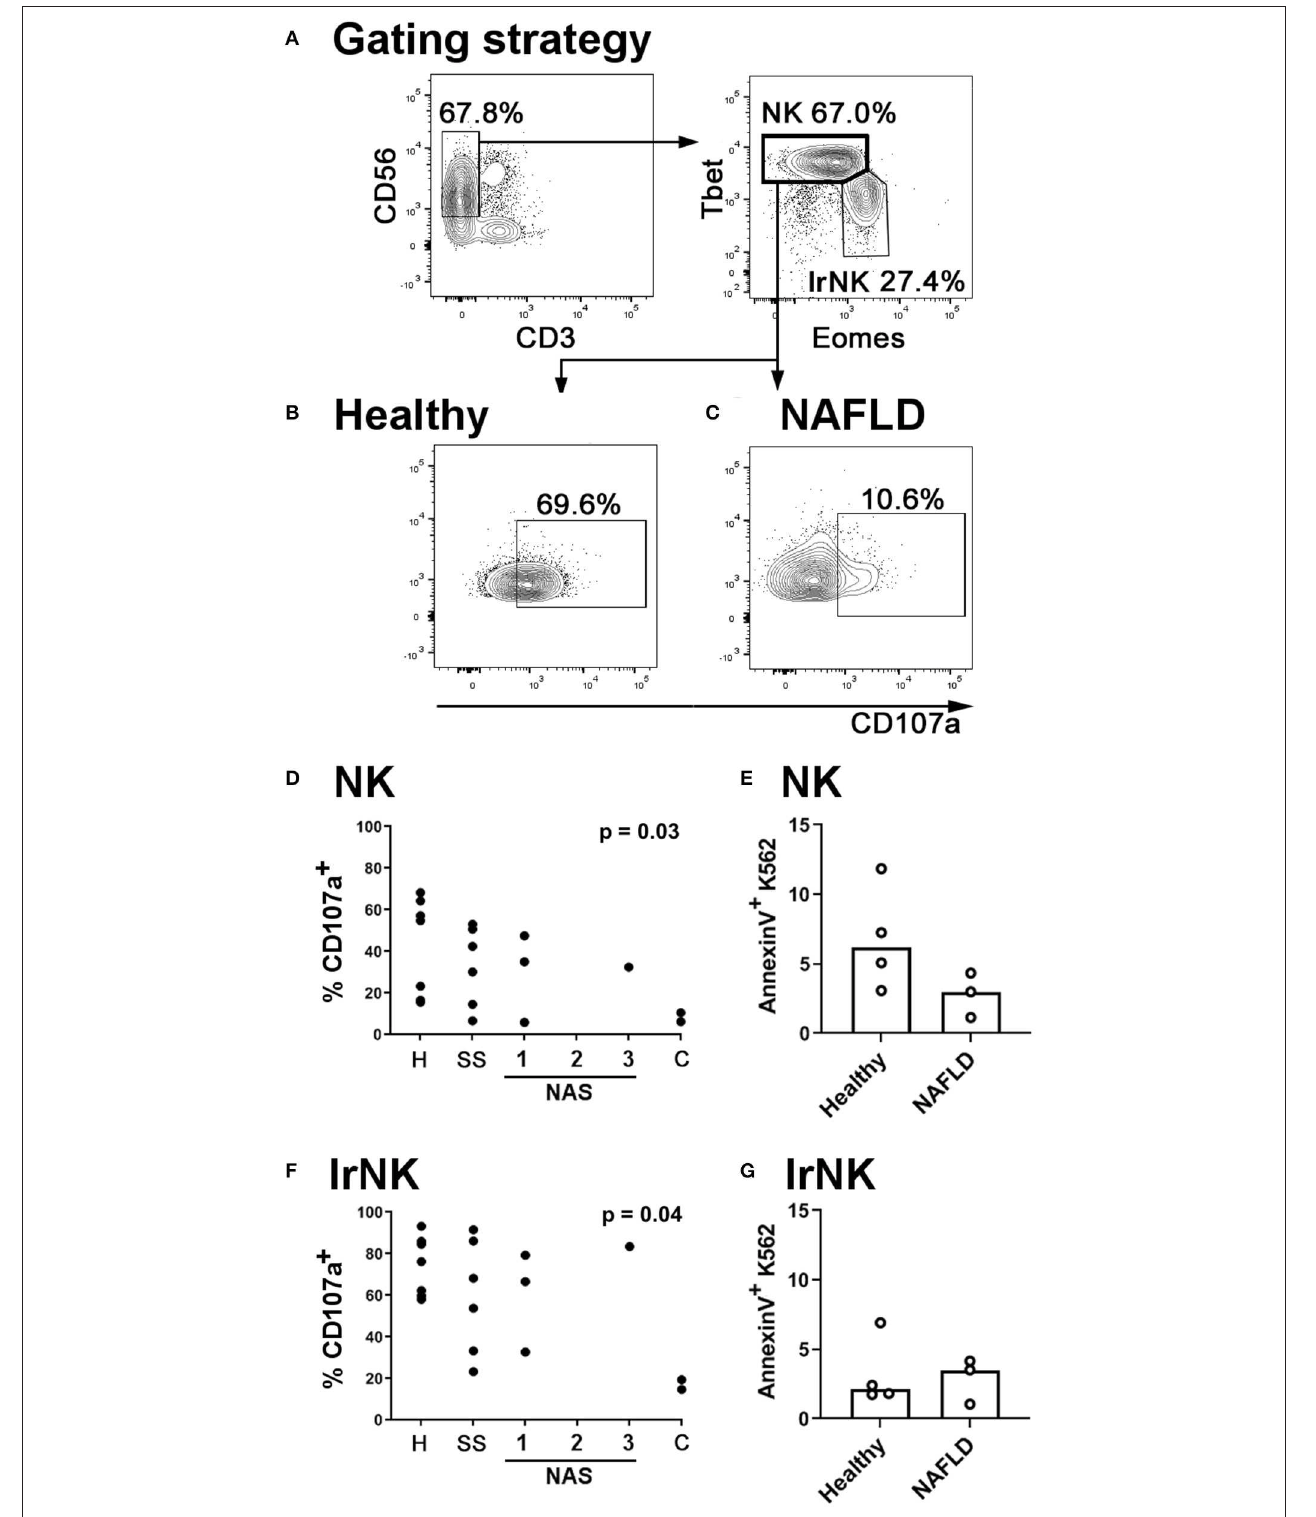
FIGURE 6 | NK cells in the livers of NAFLD patients are less cytotoxic than those from healthy controls. (A) Immune cells were isolated from human livers. NK cells were identified by scatter, and as live CD45 + CD56 + CD3 − Tbet hi Eomes lo cells. Liver-resident NK cells (lrNK) were identified as live CD45 + CD56 + CD3 − Tbet